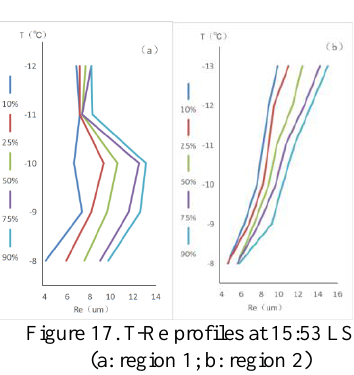
Figure 16. RGB image at 15:53 LST